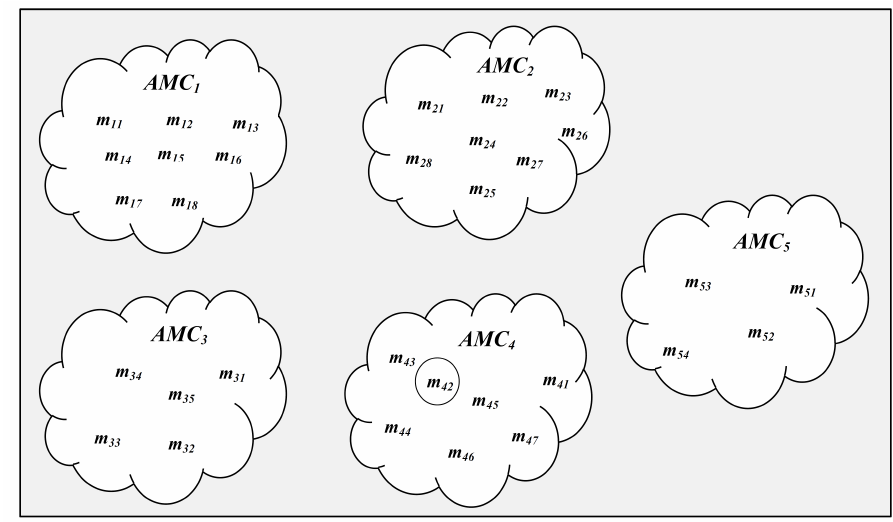
Figure 8. Resource sharing among member nodes of different AMC